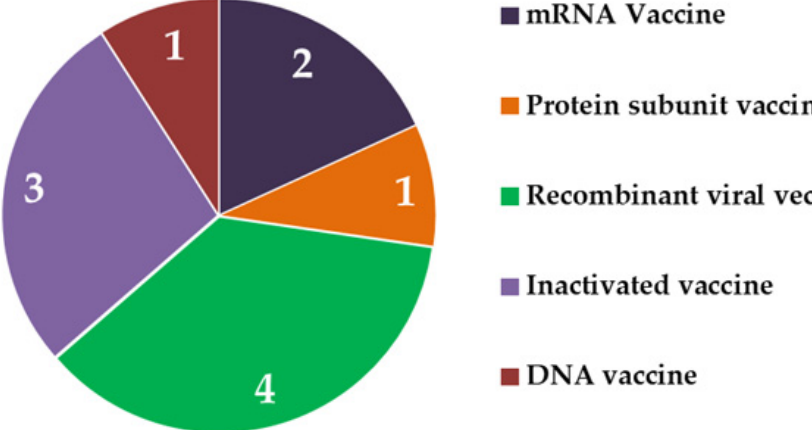
Figure 2. Distribution of approved vaccines based on vaccine types. Recombinant viral vector vaccines dominate the list followed by inactivated vaccines, mRNA vaccines, protein subunit vaccine and DNA vaccine.